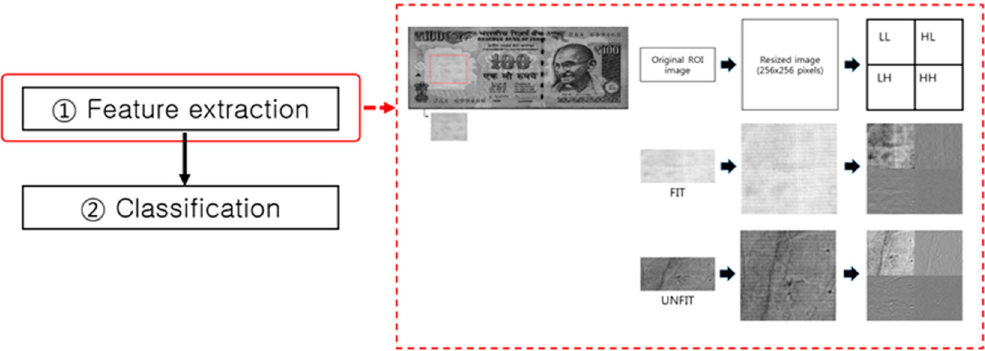
Figure 22. Feature extraction in the fitness classification process flow.